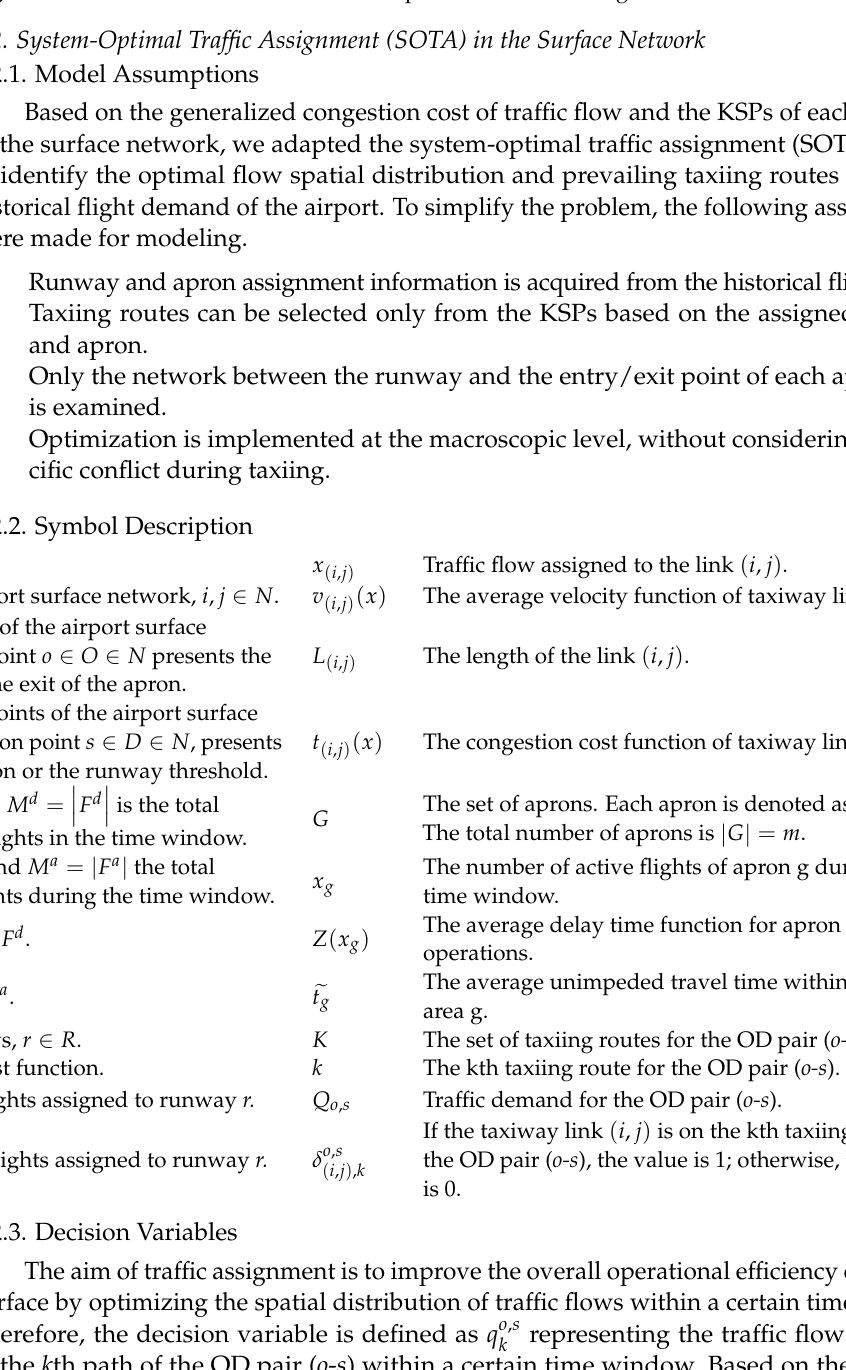
Figure 4. Schematic illustration of the concepts related to Yen’s